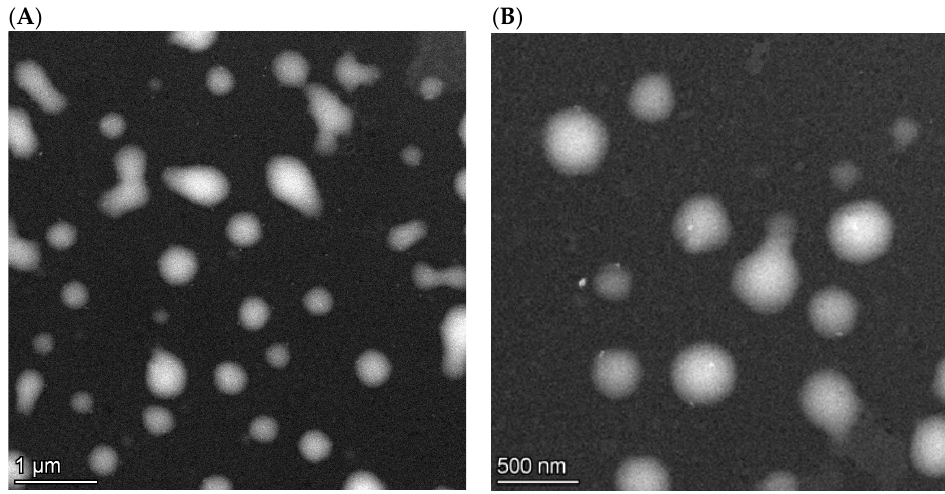
Figure 3. S/TEM images of iRGD, sorafenib, and cisplatin-loaded nanospheres (scale bars: ( A ): 1 µ m, ( B ): 500 nm). Table 6. Encapsulation of active agents and iRGD tumour homing peptide by 12CL